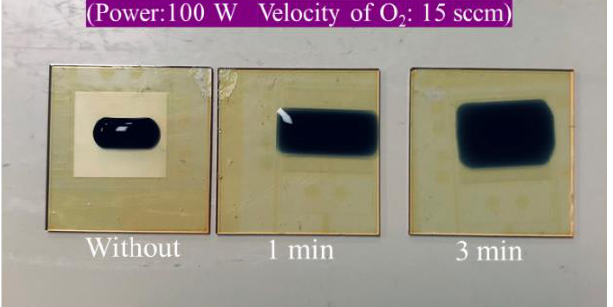
Figure 5. Effects of exposing O 2 plasma to the surface of the patterned photoresist on its wettabil- ity.